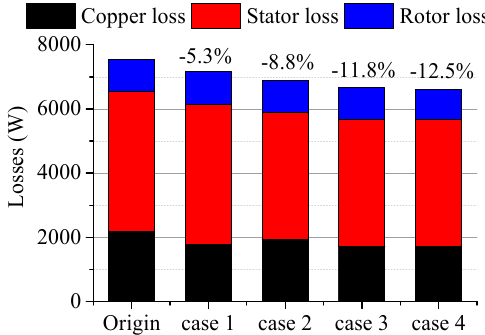
Figure 12. Evaluation of influencing factors on the total loss.